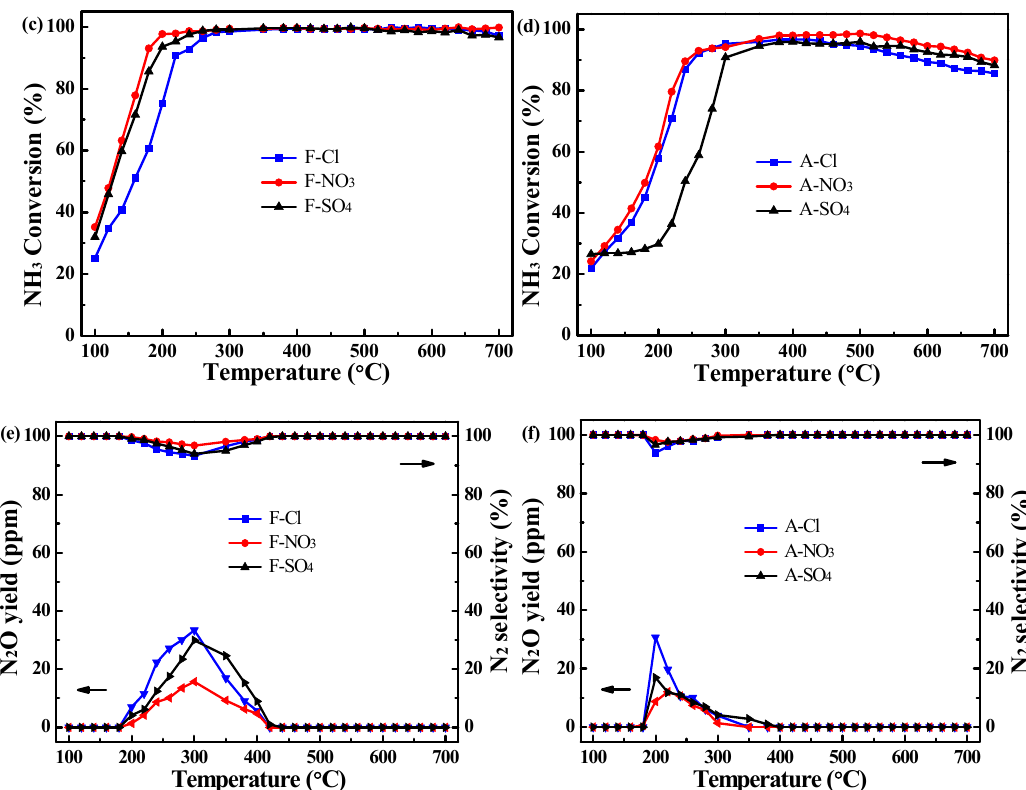
Figure 1. NO conversion ( a , b ), NH 3 conversion ( c , d ), N 2 selectivity and N 2 O yield ( e , f ) of Cu II − SSZ − 13